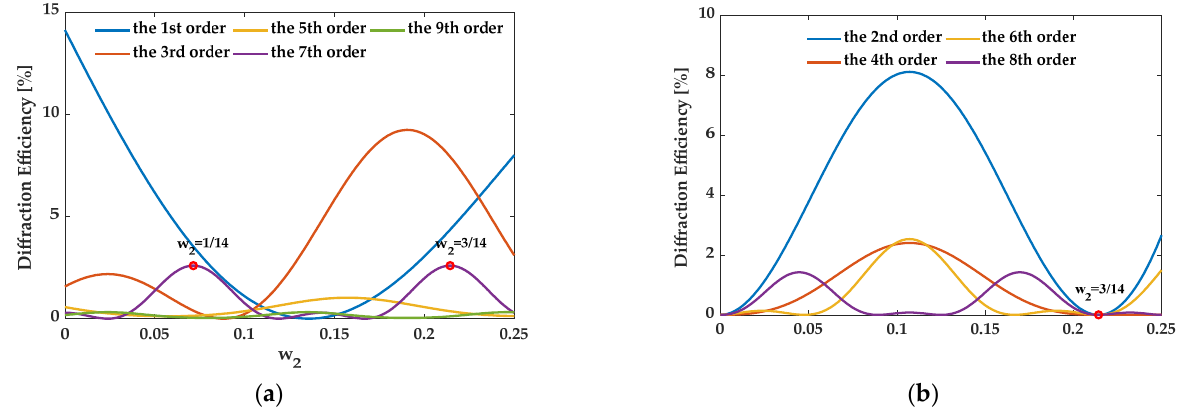
Figure 17. The diffraction efficiency of orders as a function of w 2 when { f i } is {3/14, 1/14, 3/14}. ( a ) The odd orders, ( b ) the even orders.